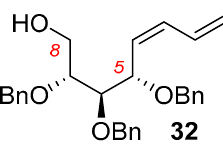
Figure 13. The structure of triene 34 and the numbering of the atoms.